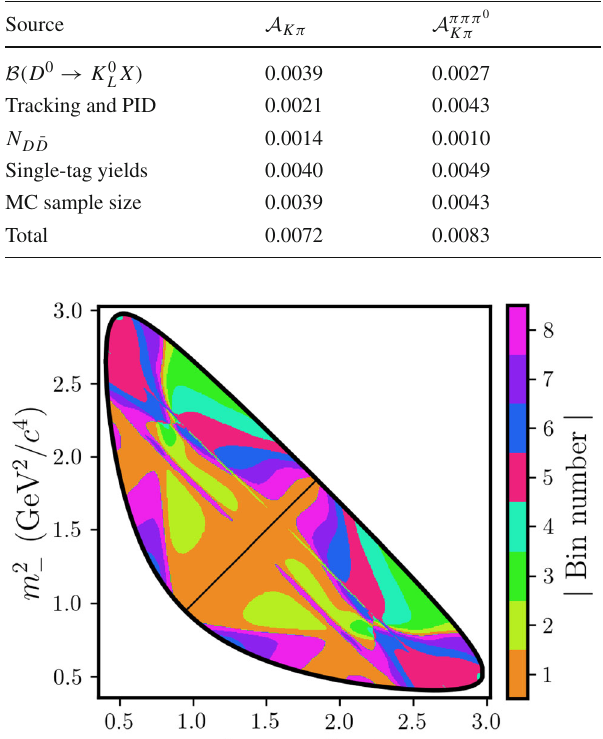
Table 5 Systematic uncertainties for A K π and A πππ 0